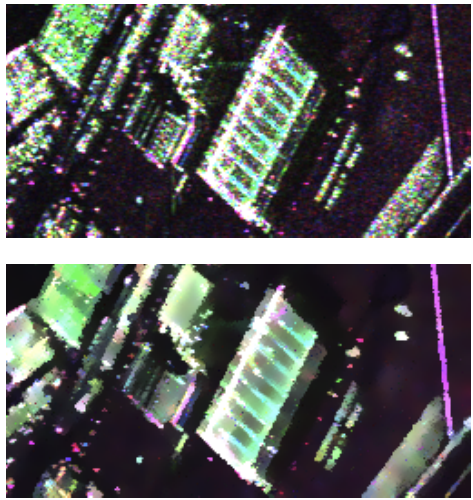
Figure 2: Pauli RGB representation of the original image (top) and the bilateral filtered one (bottom).